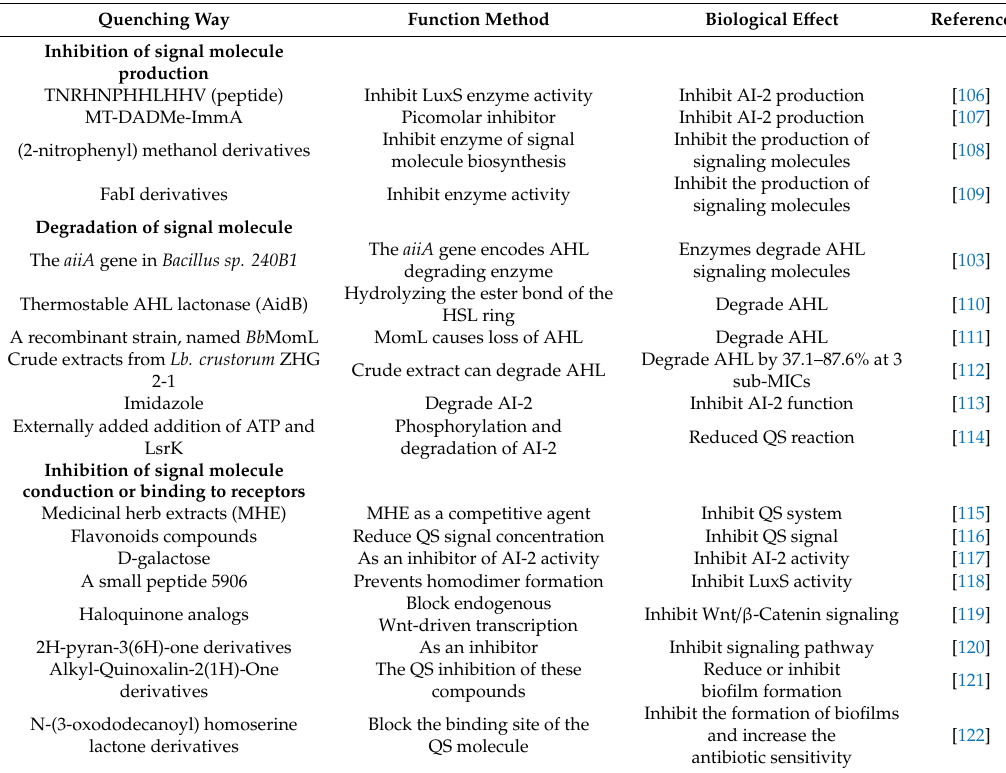
Table 3. Review of QS system inhibition